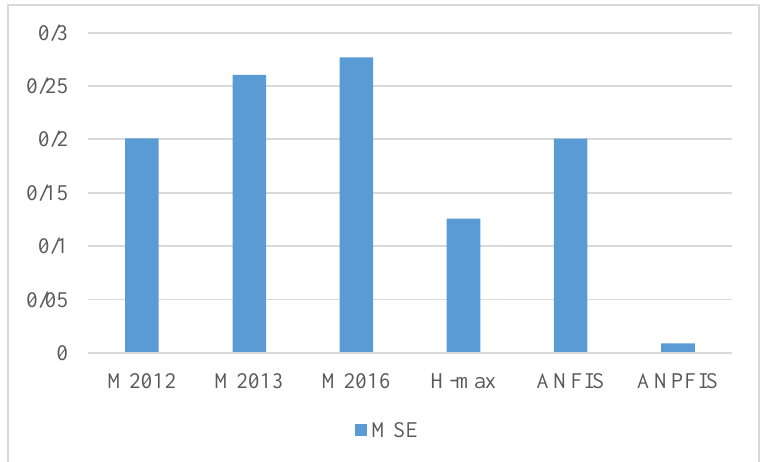
Fig. 5. The MSE values of 6